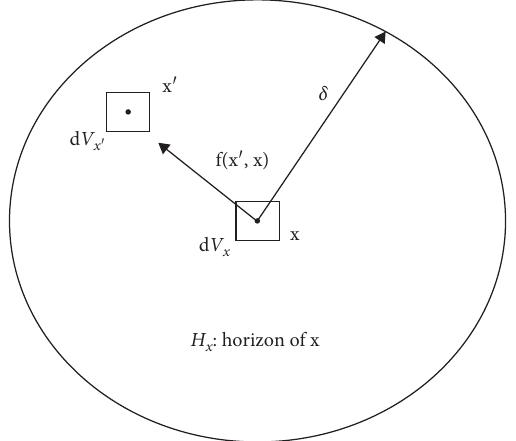
Figure 2: Pairwise bond force density